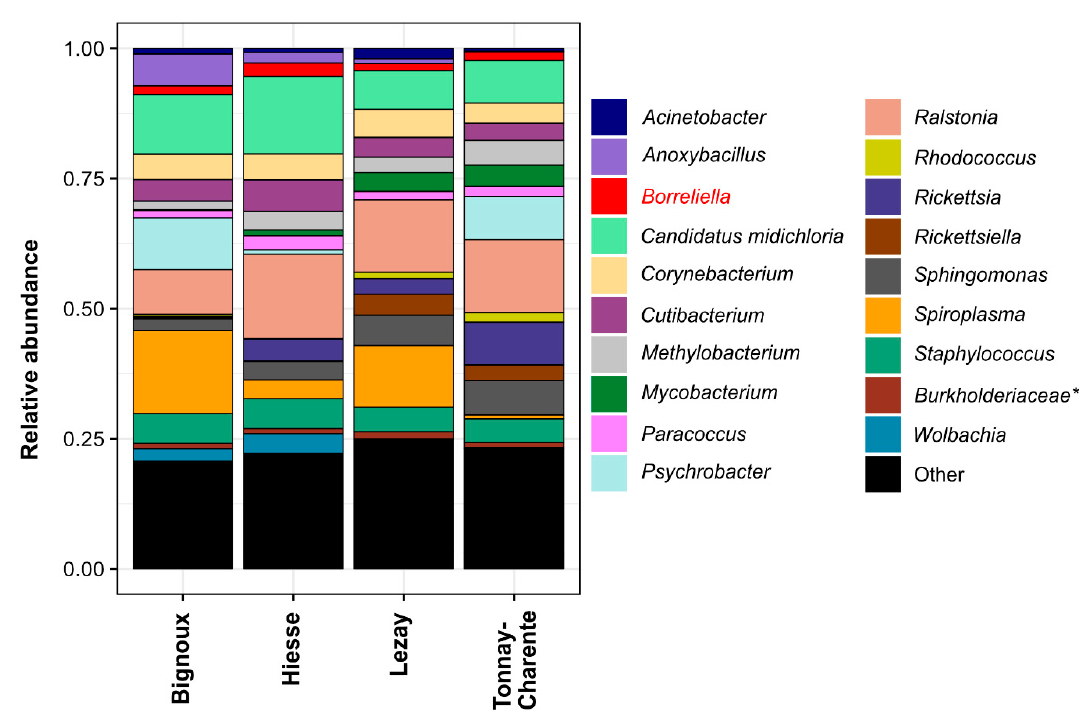
Figure 2. Relative abundance bar plot of the 20 most commonly detected taxonomic units grouped by sampling site. Taxa were classified at the genus level whenever possible. Each column represents grouped samples from a sampling site. Genera were represented depending on the overall reads number. The category « other » contains all taxa that do not belong to the 20 most abundant. Borreliella is in red because a focus on this genus is made later in the article. *: Assignment at the family level only because it was not feasible to have a more detailed assignment.